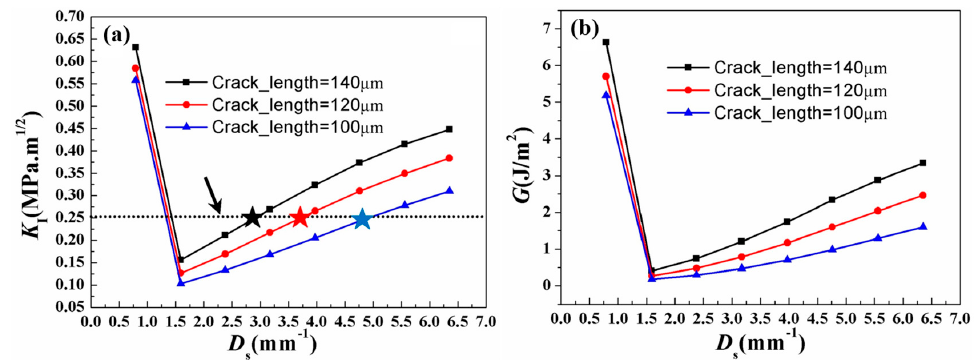
Figure 29. ( a ) The plot of stress intensity factor (the intersection point at the right side of each plotted curve can be defined as the upper crack density for the specific TTBCs with improved thermal shock resistance) and ( b ) the energy release rate of the segmentation crack as the function of the segmentation crack density [158] .